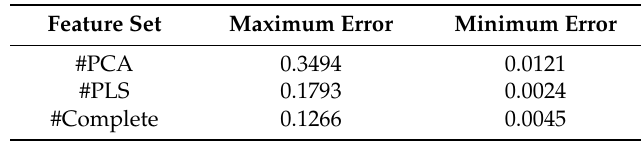
Table 6. Prediction error of different paraffin odor levels based on